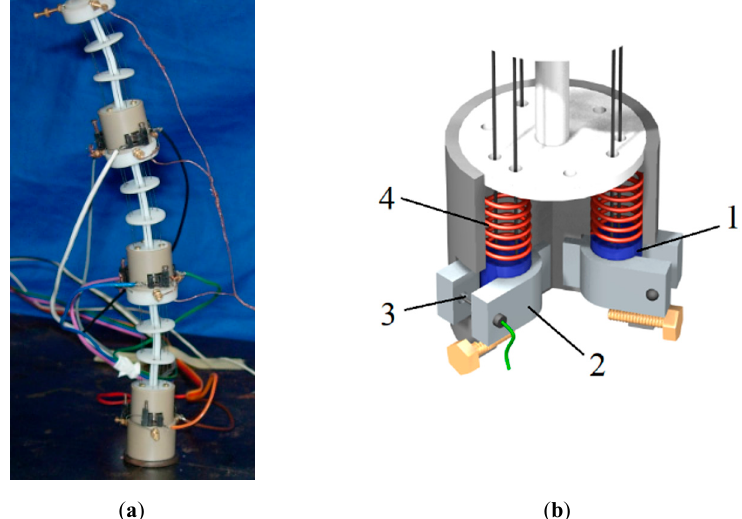
Figure 15. ( a ) New prototype D. ( b ) Detail of activation/deactivation device on the module